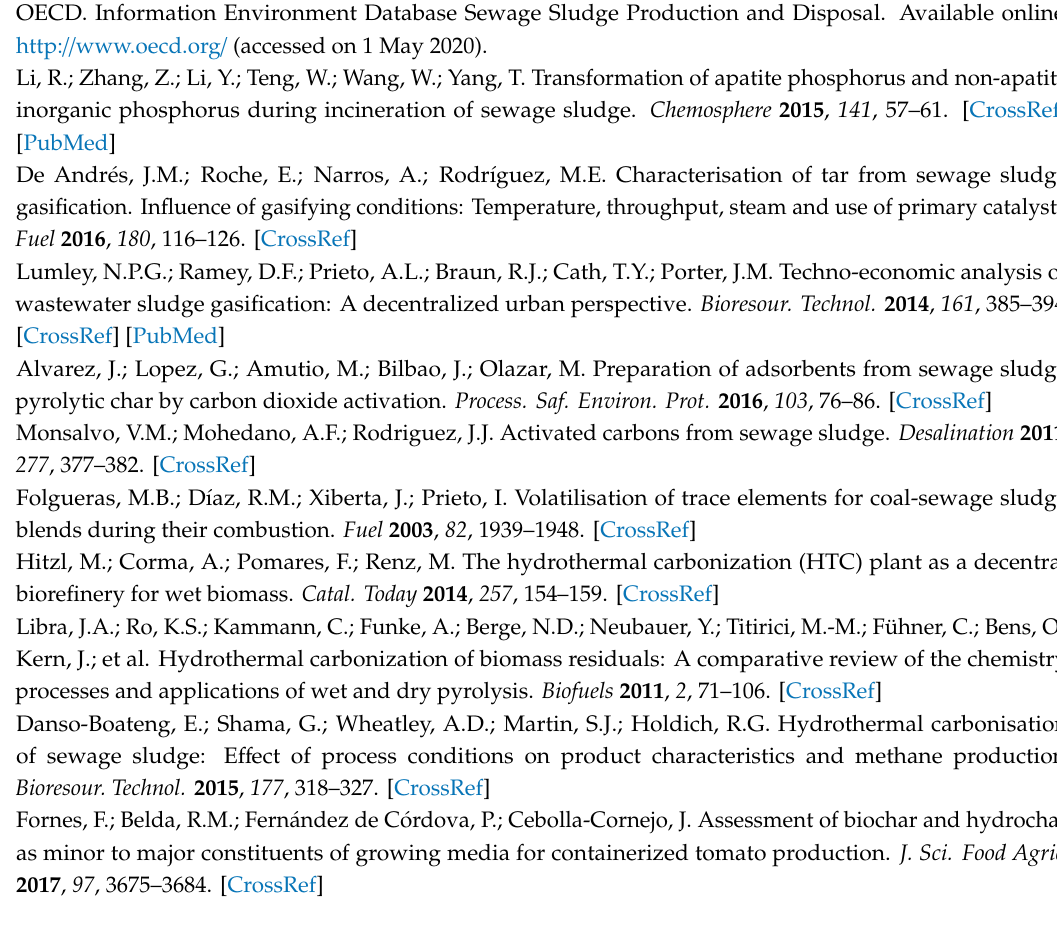
Figure S1: SEM images of DWAS (a, b), hydrochar (208 ◦ C for 1 h) (c, d), and air-activated hydrochar (325 ◦ C for 2 h) (e, f). Figure S2: SEM images of K 2 CO 3 -AC (a, b), KOH-AC (c, d), FeCl 3 -AC (e, f), and ZnCl 2 -AC (g, h) activated at 850 ◦ C for 1 h. Figure S3: FTIR spectra of dewatered waste activated sludge and carbon materials obtained at di ff erent temperatures and reaction times (a); air-activated carbons obtained at several temperatures (b); and chemically-activated carbons obtained at 650 and 850 ◦ C (c). Table S1: Assignment of Fourier